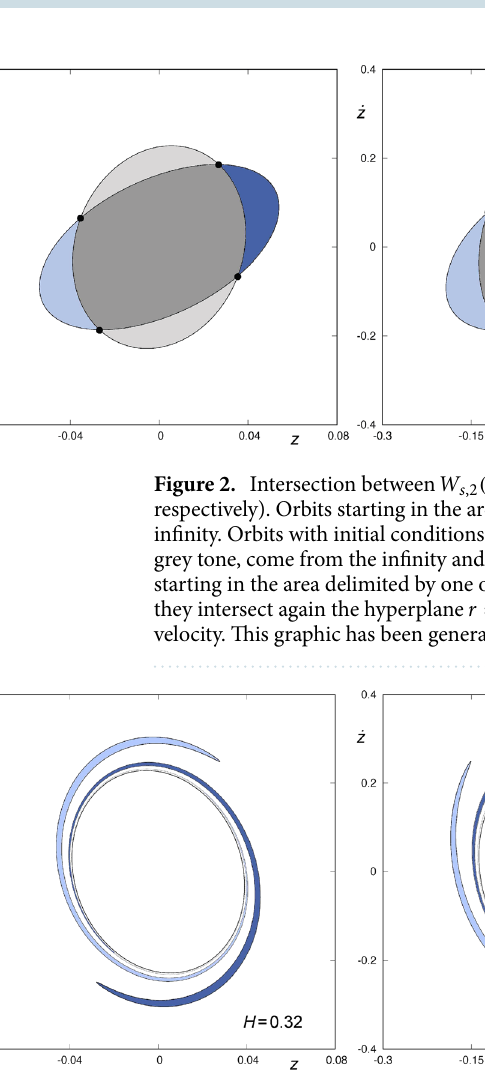
Figure 3. W s ,3 (φ) for H = 0.32, 0.36 and 0.4 (from left to right, respectively). The area enclosed by W s ,3 (φ) is colored in light and dark blue. These two blue colored infinite tongues are the result of the backward integration of the tongues colored in the same shade of blue in Fig. 2. This graphic has been generated by using Gnuplot Version 5.2. http:// www. gnupl ot.